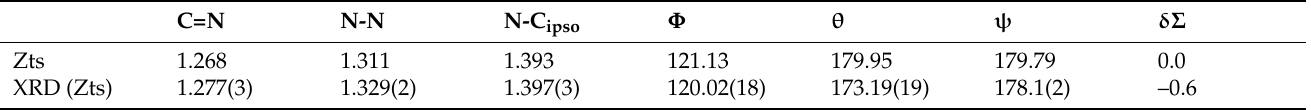
Table 7. Selected molecular geometric parameters of the Zts isomer of 3 calculated at the ω B97M- D4/cc-pVTZ level compared with those determined by XRD. Accuracy of the latter is shown in parentheses. Bond lengths are in angstrom, planar and dihedral angles are in degrees.